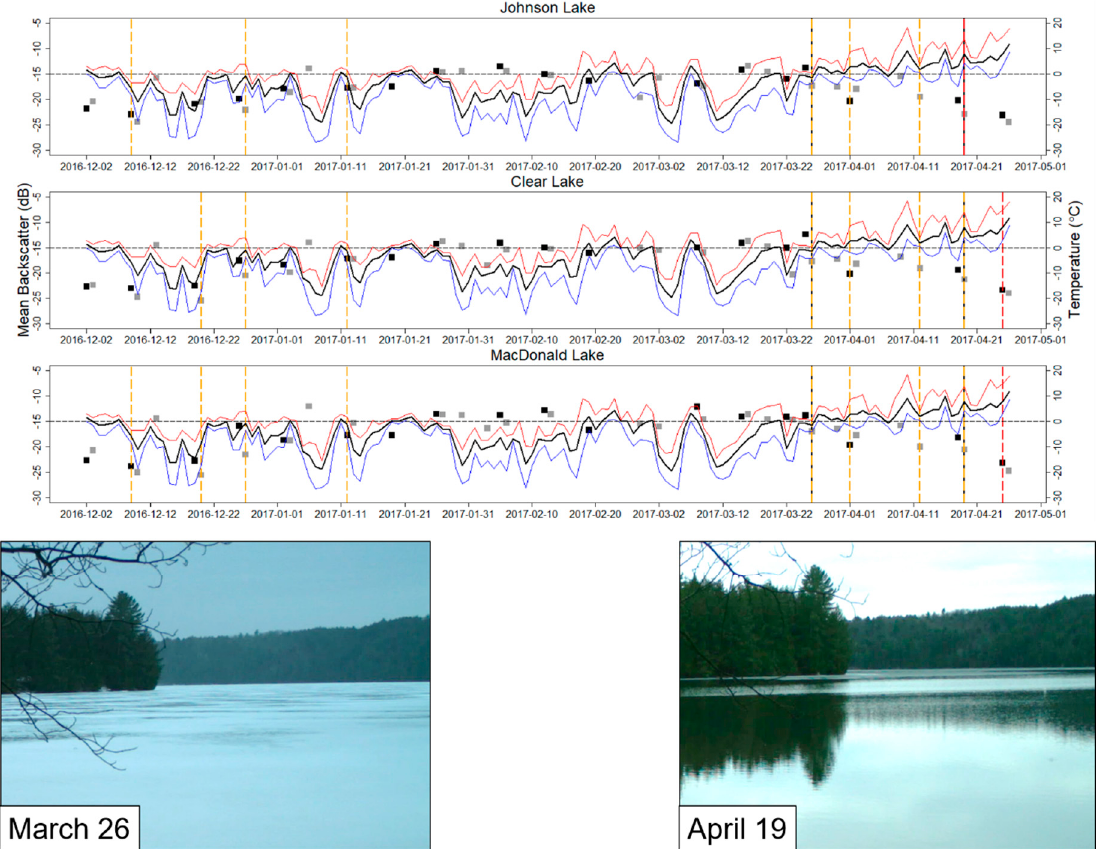
Figure 10. Backscatter and temperature evolution for the 2016/2017 ice season. Black squares represent images that were acquired in the PM and grey squares represent images acquired in the AM. The orange lines indicate when a major melt event was determined, the red lines represent WCI, and the solid lines are the dates of the sample images. These two images are from the lake ice monitoring network and display the surface conditions on MacDonald Lake corresponding to the respective event.